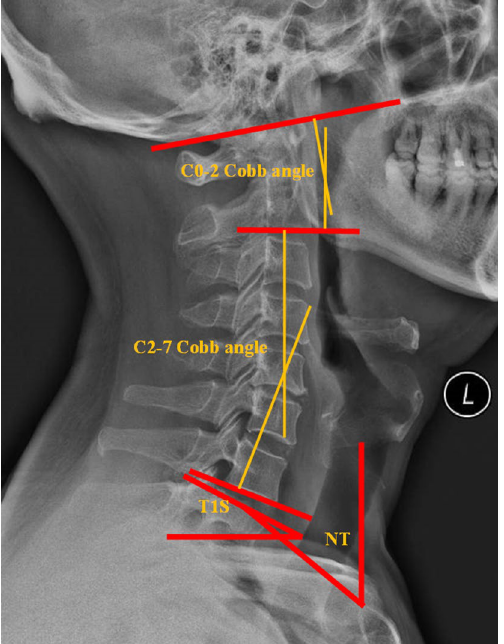
Figure 1. The definition of the C0-2 Cobb angle, C2-7 Cobb angle, T1S and